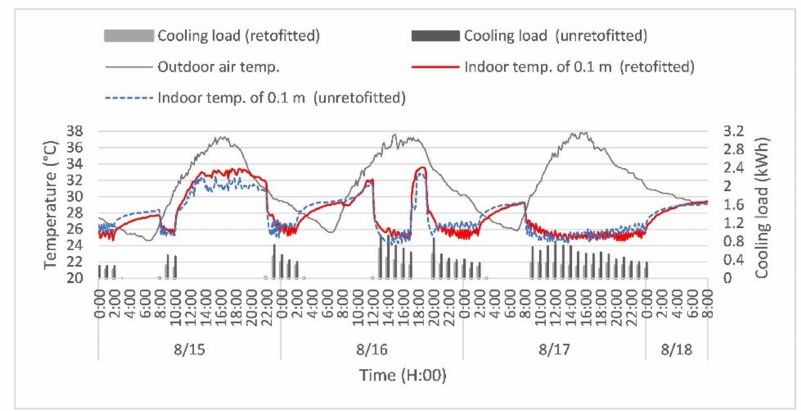
Figure 15. Comparison of indoor temperature and hourly cooling load at 0.1